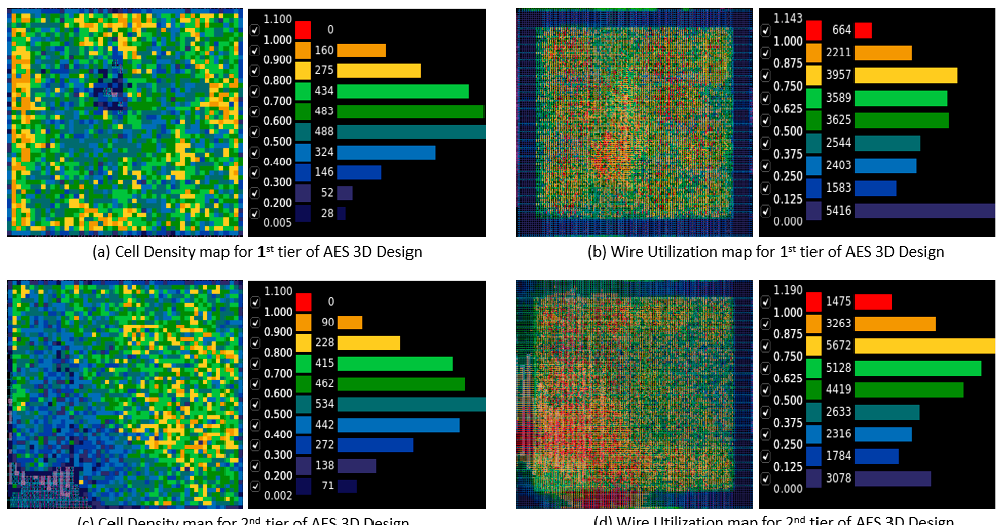
Figure 13. Cell density and wire utilization plots for two-tier FFT 3D designs using the AQ partitioner.